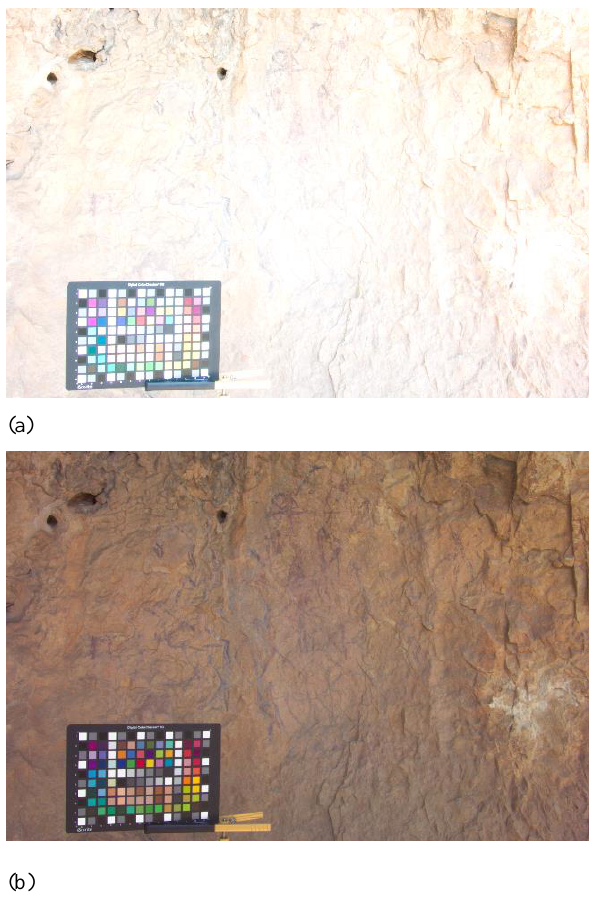
Figure 9. Image SDIM0505.X3F: a) Original RGB image; b) sRGB output